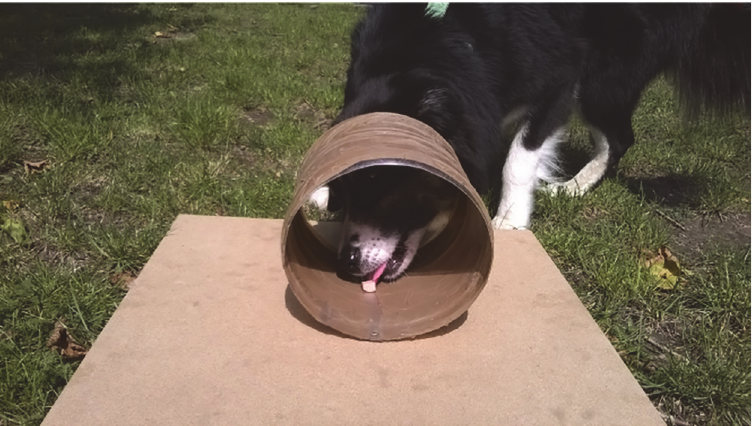
Fig 2. The opaque cylinder used in training trials. The exact same apparatus, but transparent, was used in test trials.